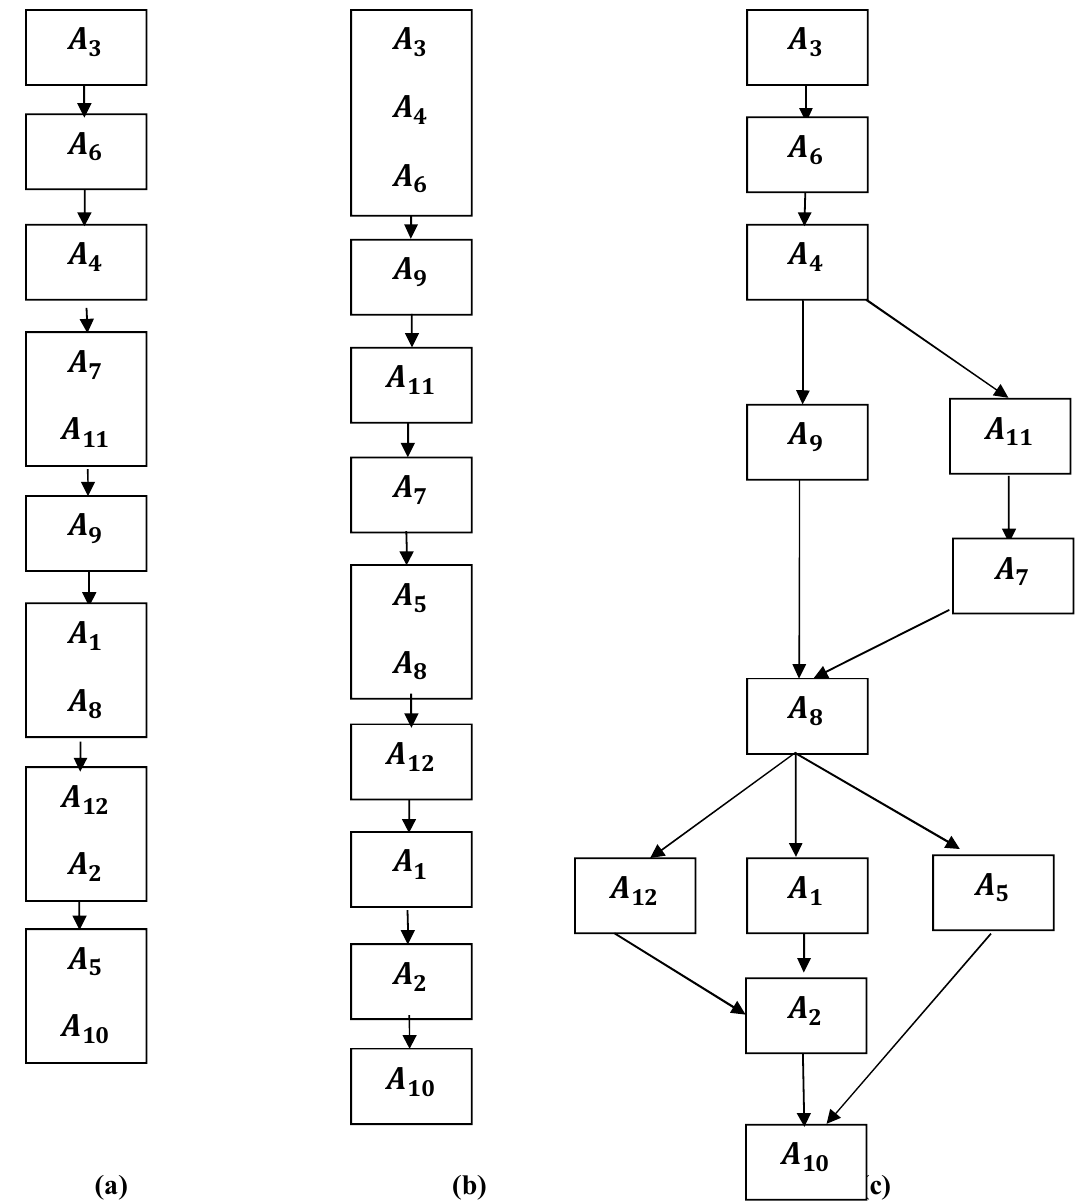
Fig. 3. (a) Descending Distillation, (b) Ascending Distillation, (c) Final Ranking Sensitivity analysis: results of 10% change in thresholds p and q.